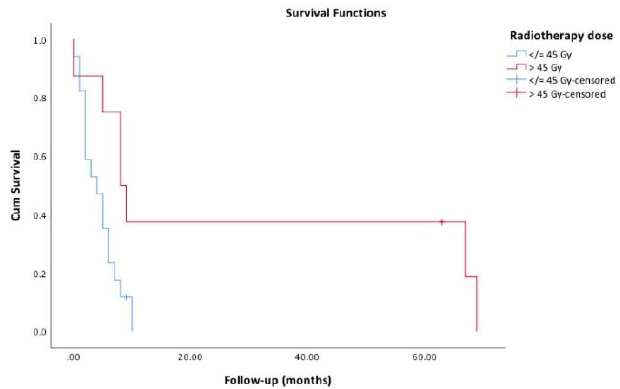
Figure 3. Survival functions regarding radiotherapy dose (≤45 Gy vs > 45 Gy) .